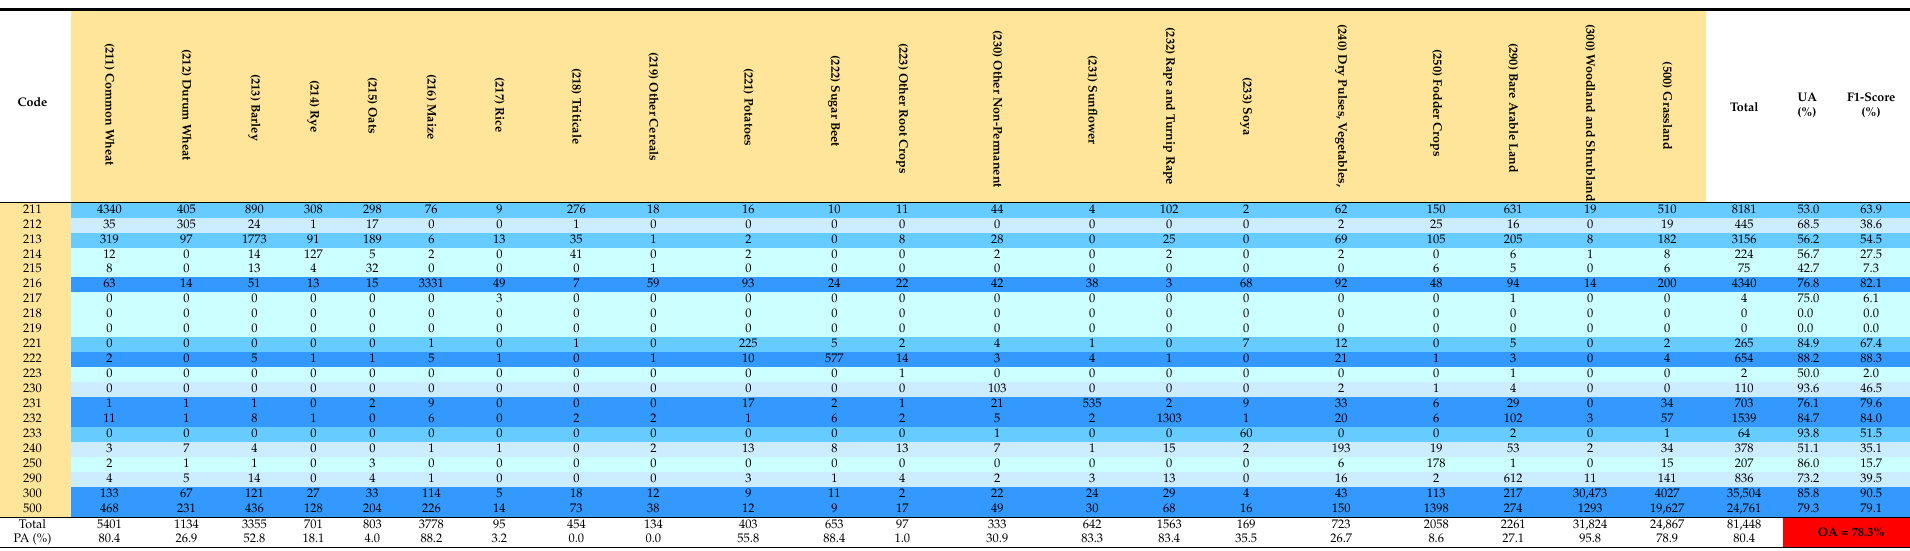
Table A1. The confusion matrix extracted from the RF classification result on validation data using the S1DS2Y feature set. UA = User Accuracy, PA = Producer’s Accuracy, OA = Overall